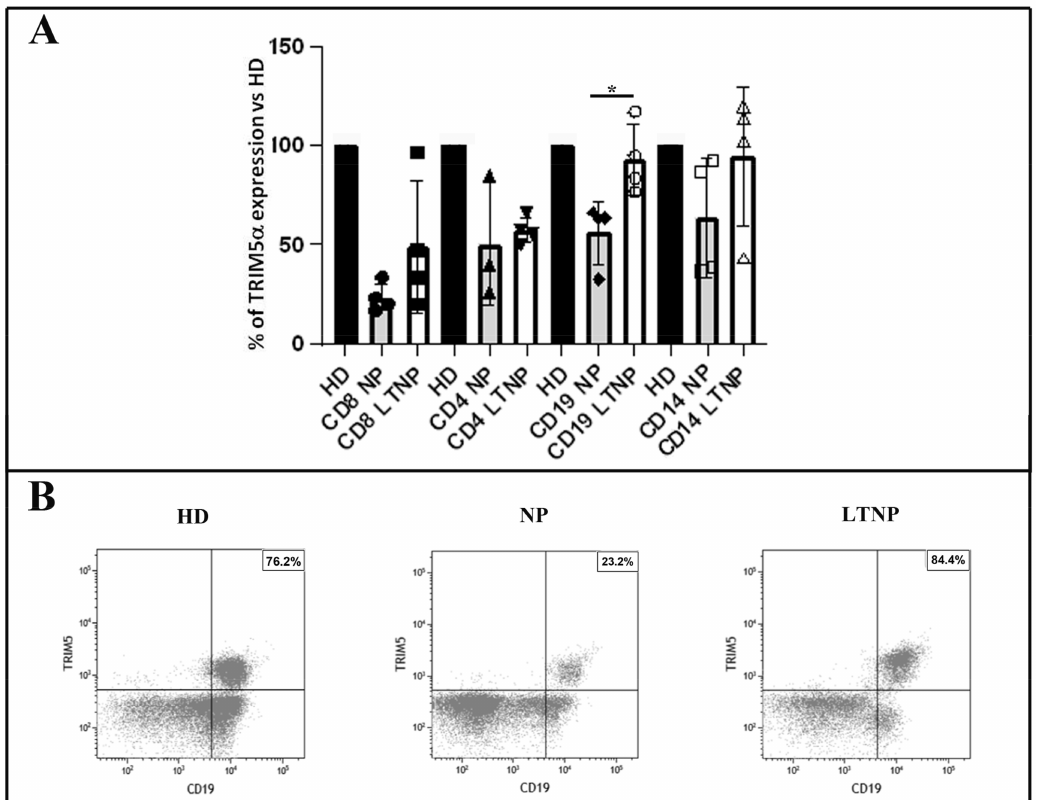
Figure 2. Expression of TRIM5 α in PBMC cell populations. ( A ) The graphs show TRIM5 α expression in specific PBMC cell subpopulations, namely, T CD4, T CD8, monocytes CD14 and B CD19 cells. Data have been obtained from 7 HD, 4 NP (Patients No. 2, 5, 11, and 14) and 4 LTNP (Patients No. 1, 5, 8, and 9) normalized to HD. In the graph, data are reported as scatter plots with means values ± s.d. * p < 0.05. ( B ) Representative flow cytometric panels showing TRIM5 α + expressing B cells (CD19+) in HD, LNTP and NP. Percentage of TRIM5 α + expressing CD19+ cells among total B cells are depicted in each panel (upper-right quadrant). PBMC were first gated including only singlet cells, then as live cells (7AAD-), and finally, among CD3-negative cells, CD19+ TRIM5 α + cells were selected. HD, healthy donors; NP, HIV-1-infected normal progressor patients; LTNP, long-term